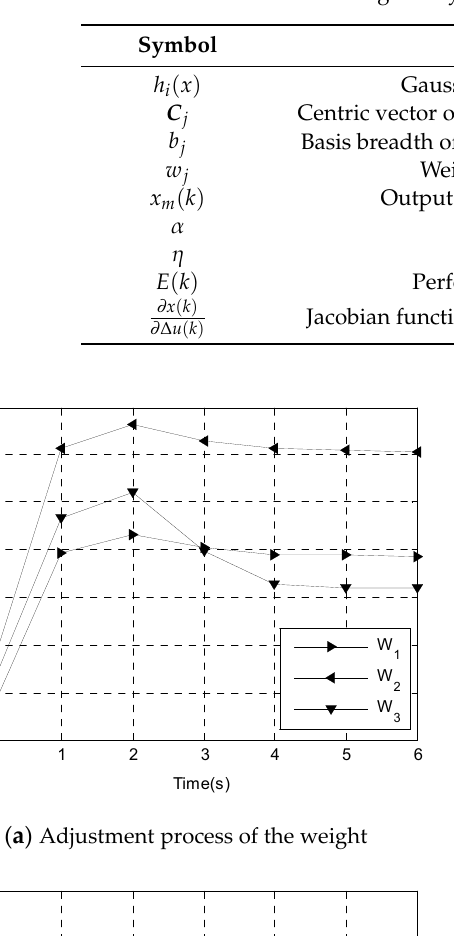
Table 2. Definitions of the given symbols of the RBF neural network.